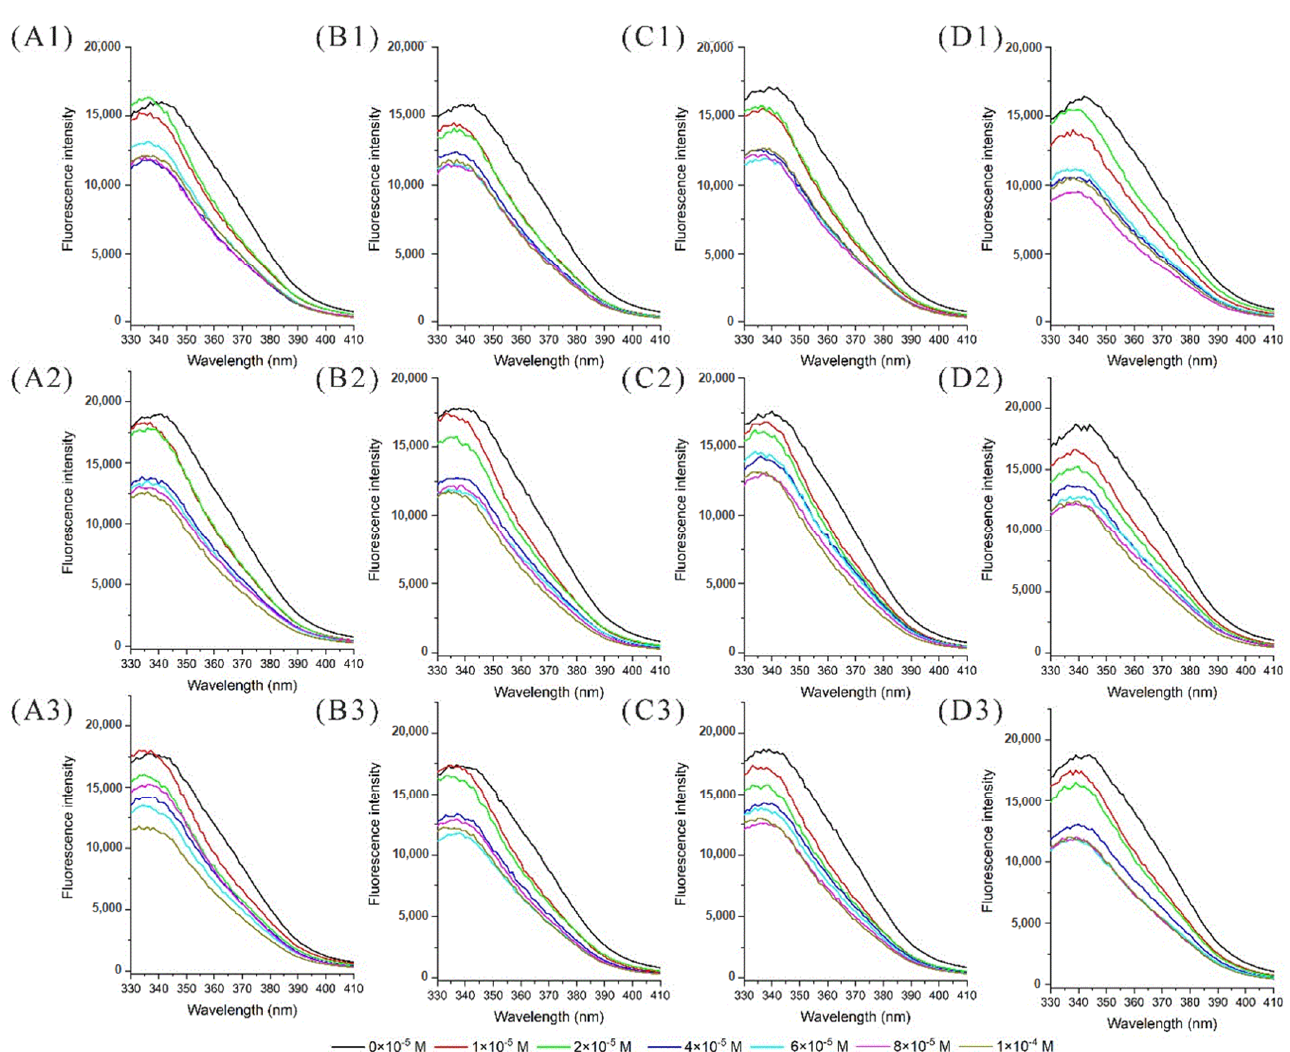
Figure 1. The fluorescence spectra of α-lactalbumin at different thermal treatments. ( A – D ): The fluorescence intensity of α-lactalbumin at 20 °C, 40 °C, 60 °C, and 80 °C, respectively; ( 1 – 3 ): the fluorescence intensity of α-lactalbumin at pH of 6.0, 7.4, and 8.0, respectively. To examine the effects of thermal treatments on the quenching reactions of a-La and P3G, the Stern–Volmer equations were established by calculating the ratios of the fluores- cence intensity in the absence and presence of anthocyanin (F 0 /F). The quenching con- stants and accessible fractions under the thermal treatments are shown in Table 1. The thermal treatments significantly increased the quenching constants at pH 7.4 and 8.0 with